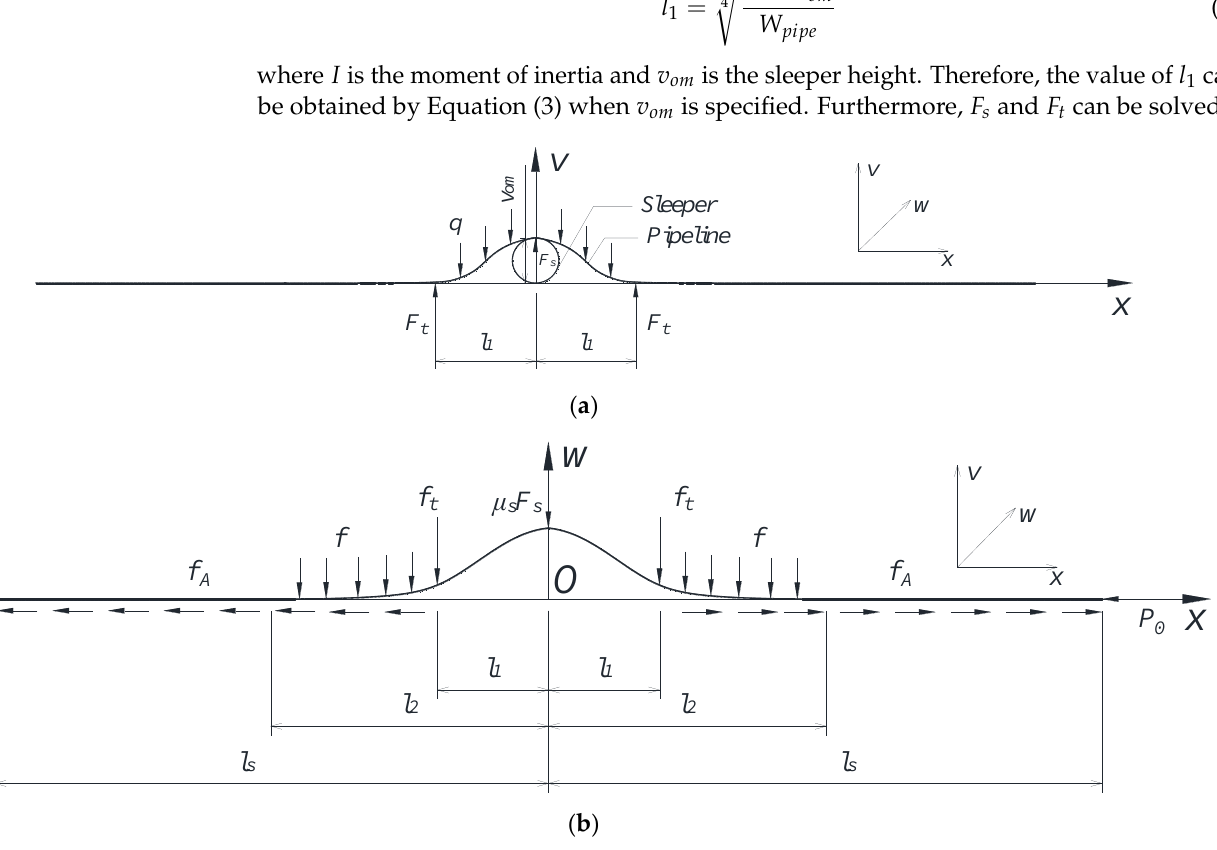
Figure 1. Configuration and load distribution. ( a ) Vertical plane. ( b ) Horizontal plane.